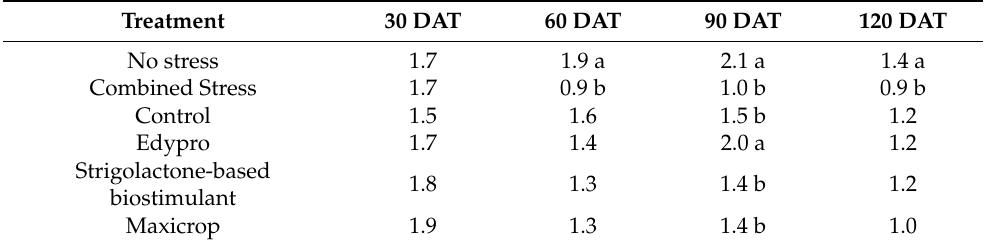
Table 3. Effects of combined restriction of water and nutrients (No stress, NS; Combined stress, CS), and biostimulants application (Control: No biostimulant applied, Edypro: application of COUP É REGENERACI Ó N and PROCUAJE RADICULAR, strigolactone-based biostimulant and Maxicrop) at P concentration (mmol L − 1 ) on tomato root zone 30, 60, 90, and 120 days after transplanting